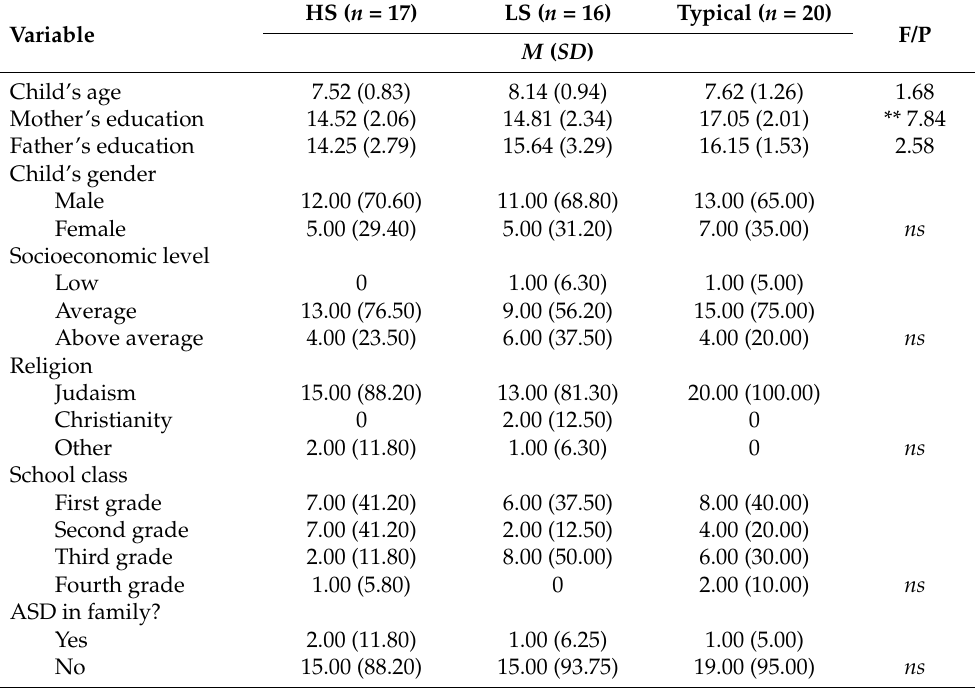
Table 1. Demographic characteristics by